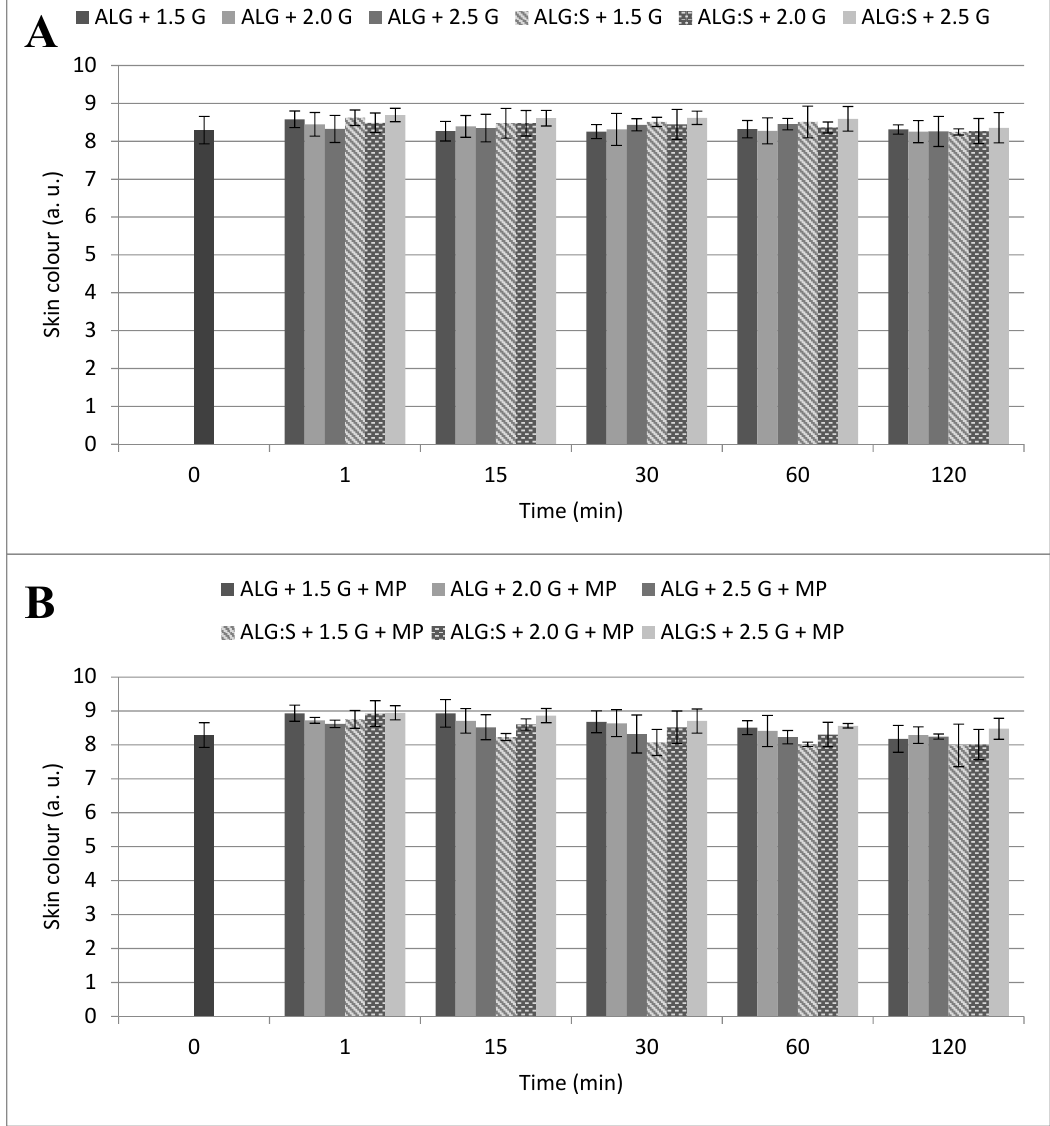
Figure 6. Skin color after application of sodium alginate and sodium alginate/starch films ( A ) without and ( B ) with microspheres in the structure: ALG + 1.5 G, ALG + 2.0 G, ALG + 2.5 G—samples based on sodium alginate containing 1.5%, 2%, and 2.5% of glycerin, respectively. ALG: S + 1.5 G, ALG: S + 2.0 G, ALG: S + 2.5 G samples based on sodium alginate and starch containing 1.5%, 2%, and 2.5% of glycerin, respectively.